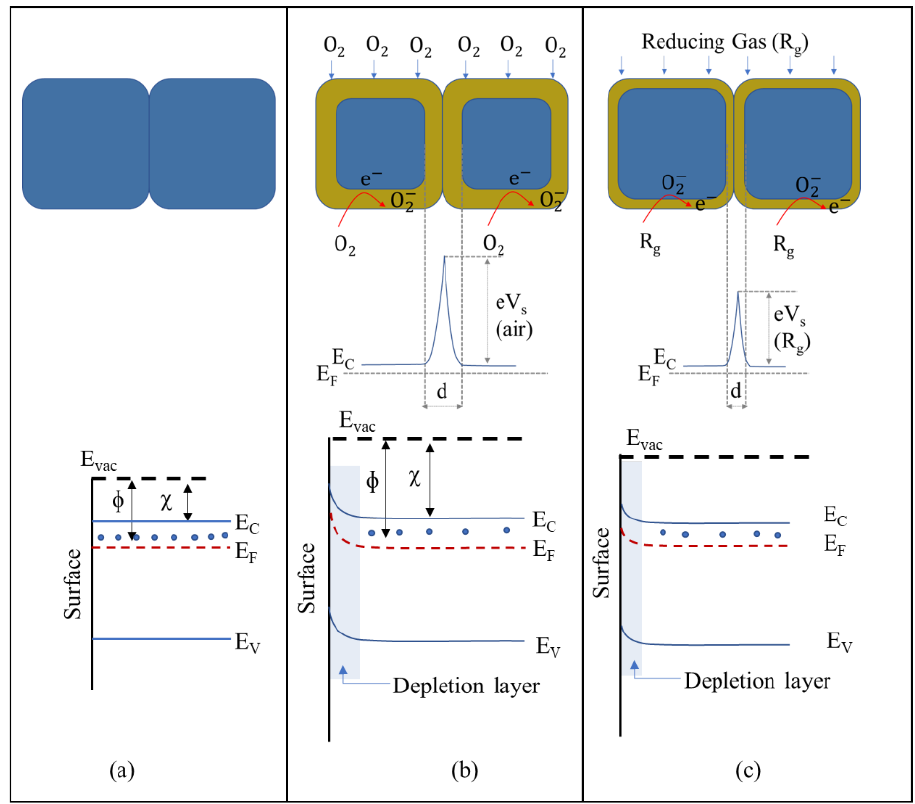
Figure 6. Energy-band diagram of a typical n-type MOX semiconductor: ( a ) flat band, ( b ) when an electron-depletion layer is formed due to chemisorption of oxygen molecules, and ( c ) when a reducing gas interacts with oxygen species.